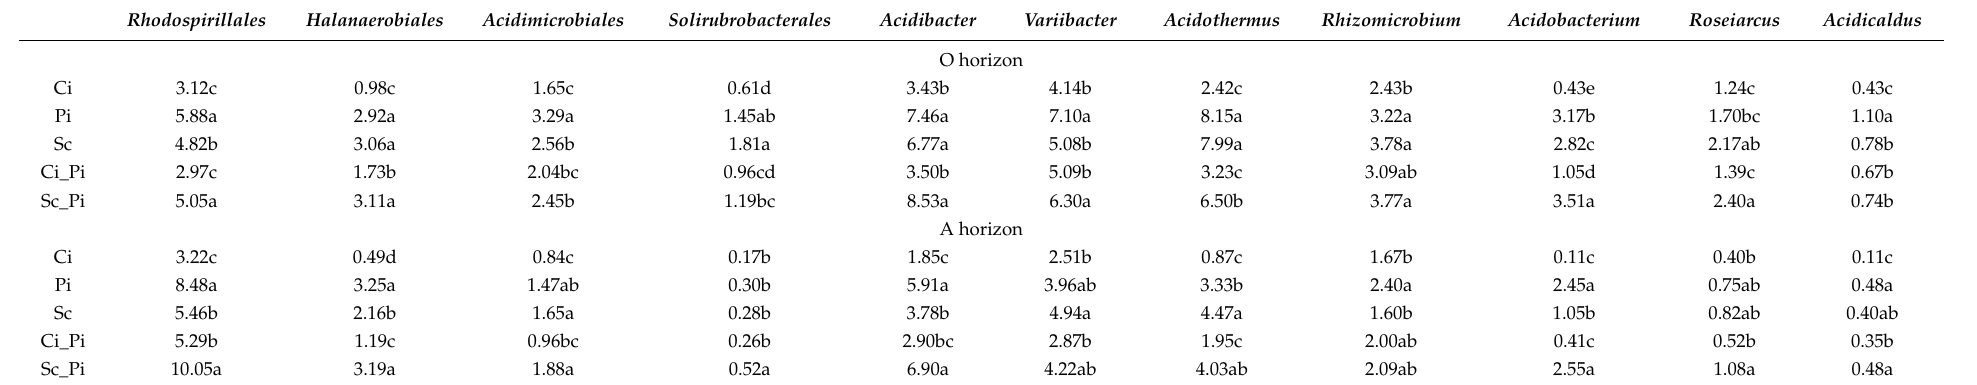
Table 2. The soil bacteria that were significantly more abundant in Sc, Pi, and Sc_Pi than those in the other two forests. Different letters indicate a significant difference among forest types, respectively in the O horizon and A horizon.